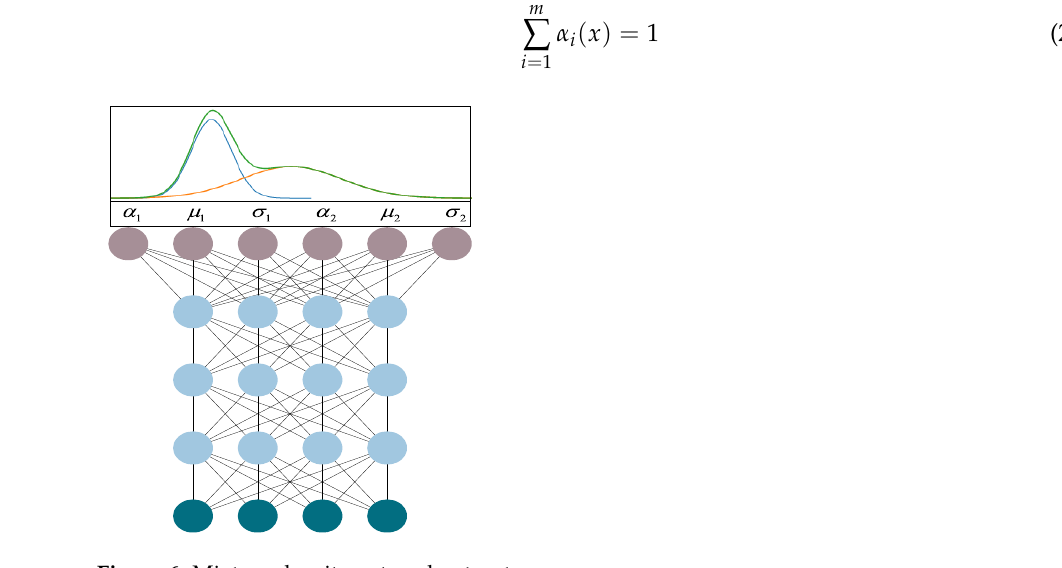
Figure 6. Mixture density networks